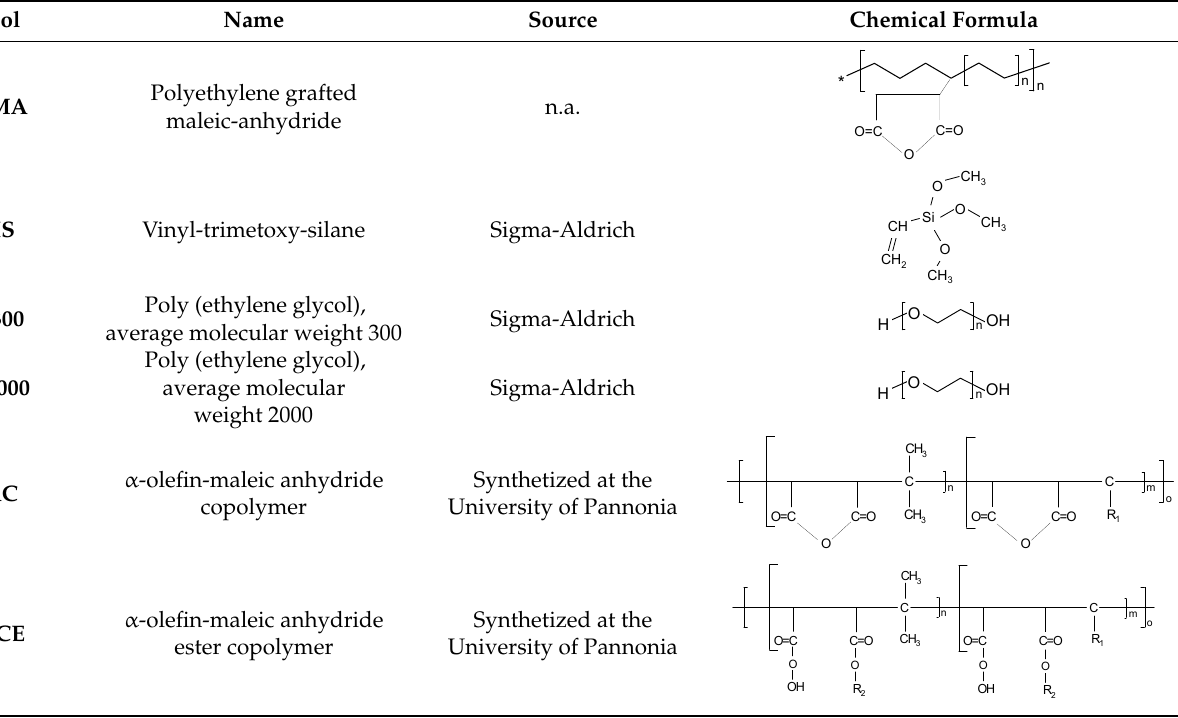
Table 2. The used chemicals for coupling of NC/PLA composites.